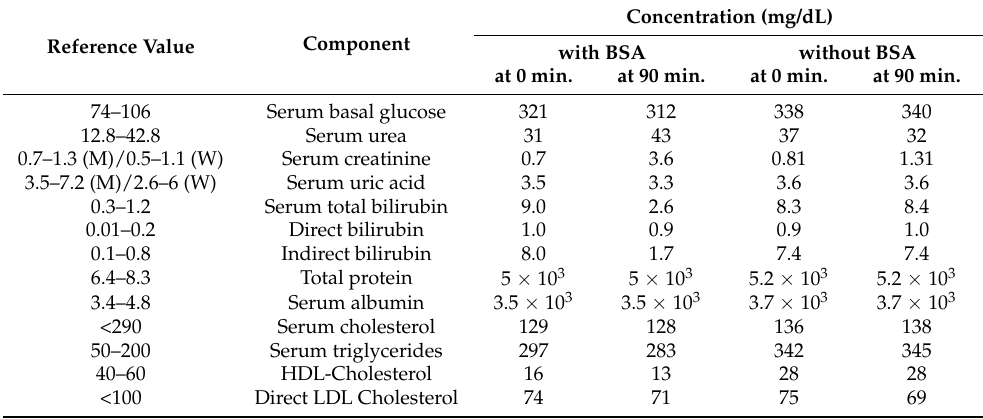
Table 6. General biochemical analyses of plasma in contact with St-MMA-GMA-PEGMA particles, with and without BSA, wetted in ethyl